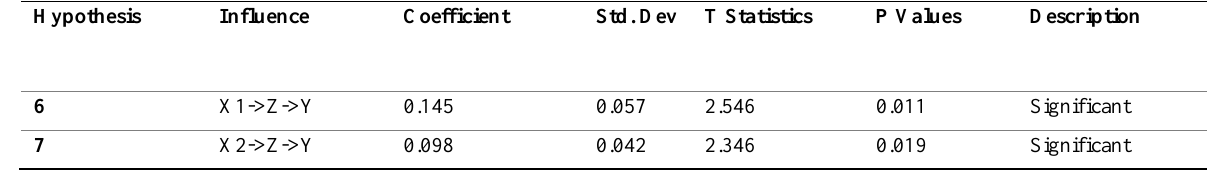
Table 7: The Results for Hypothesis Test in Indirect